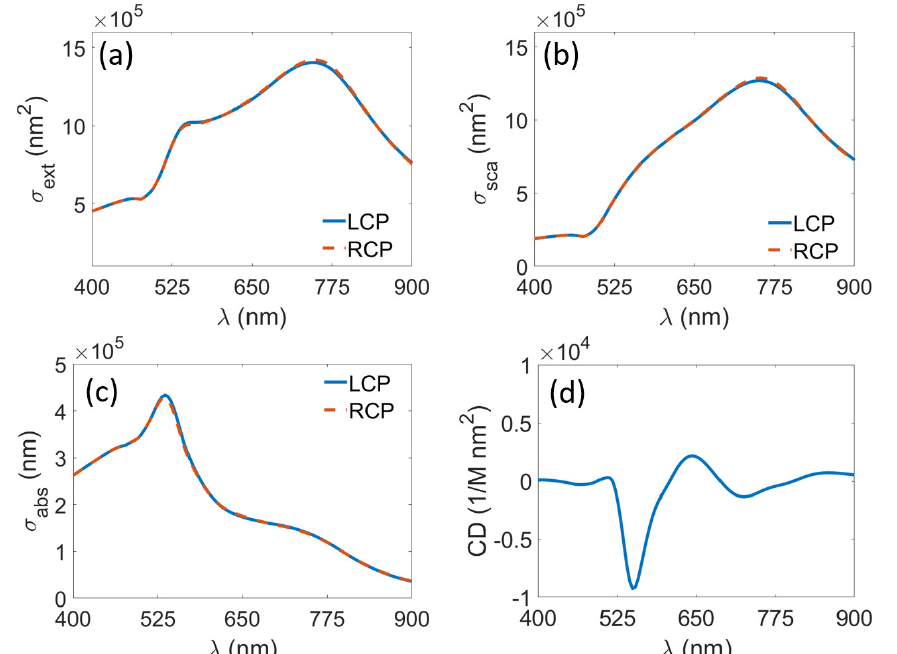
Figure 4. Average ( a ) extinction; ( b ) scattering and ( c ) absorption cross section of gold nanospheres arranged in a helix for different polarization of incident field. The brown dashed lines denote right handed polarization, while the blue straight lines denote the left handed polarization and ( d ) circular